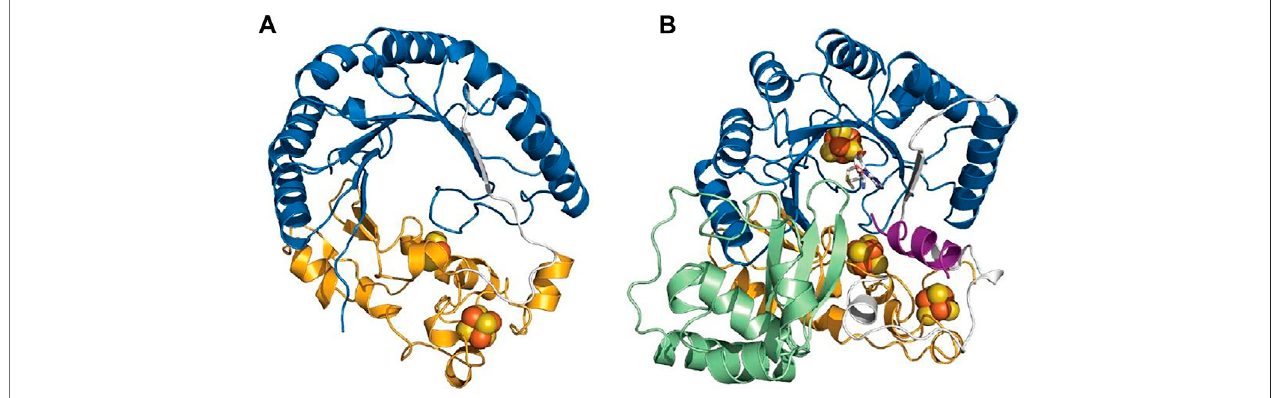
FIGURE8| StructuresofradicalSAMenzymescatalyzingC – Cbondformation.PqqE (A) andSuiB (B) .TheradicalSAMdomainisdepictedinblue,theN-terminal RRE domain is colored in green, and the C-terminal SPASM domain is shown in orange.